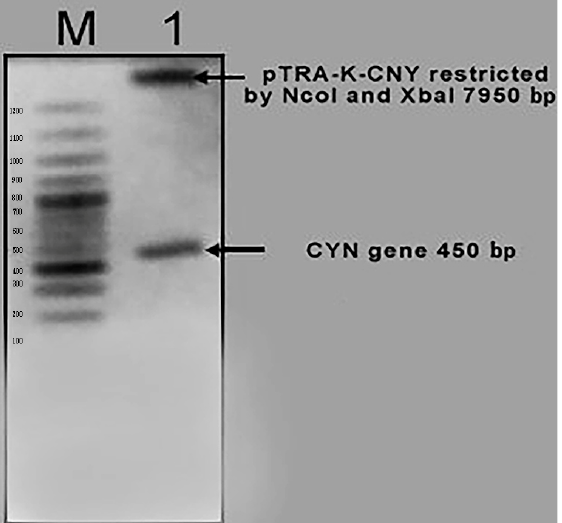
Figure 3. The generation of the right pTRA ‐ K ‐ CYN clones with right pattern, as expected (450 bp + 7950 bp). 7950 bp).